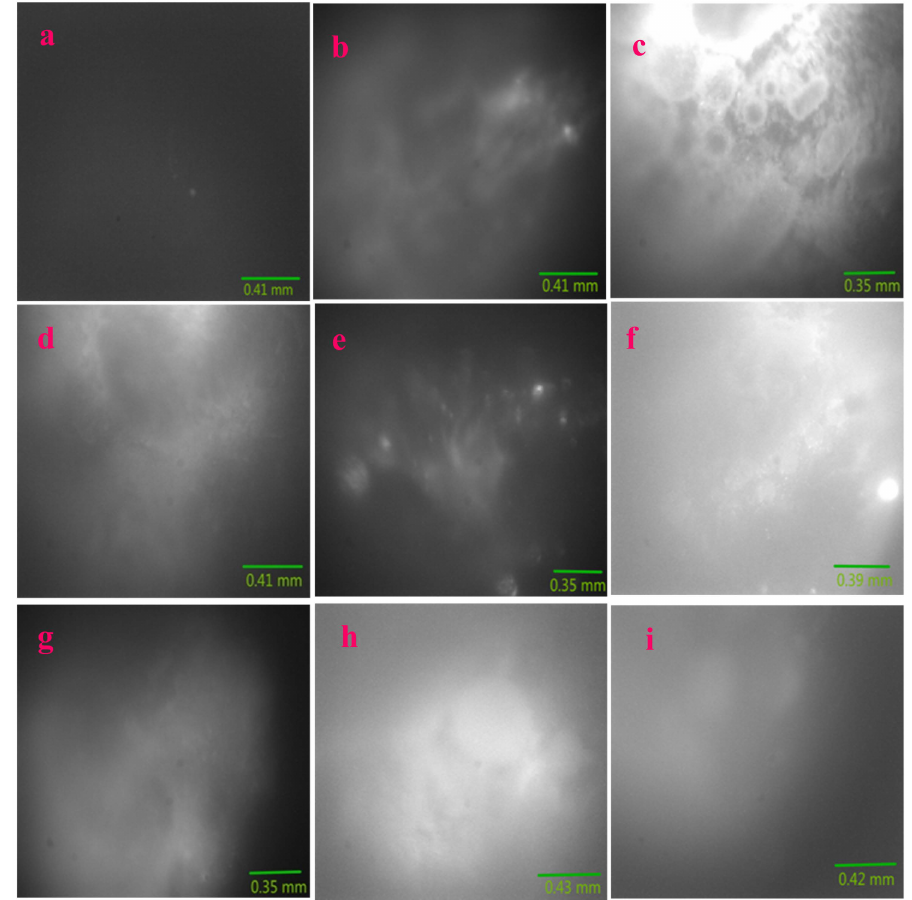
Figure 11. 785 nm Laser was used to generate NIR Fluorescence images of pig kidney coated with Sm–Me (Me = Fe, Ga, Mn, Na, Nb, W, Cu, and Al) nanoparticles: ( a ) Control (no nanoparticles are used); ( b ) Sm–Fe; ( c )Sm–Ga; ( d ) Sm–Mn; ( e ) Sm–Na; ( f ) Sm–Nb; ( g ) Sm–W; ( h ) Sm–Cu; ( i )